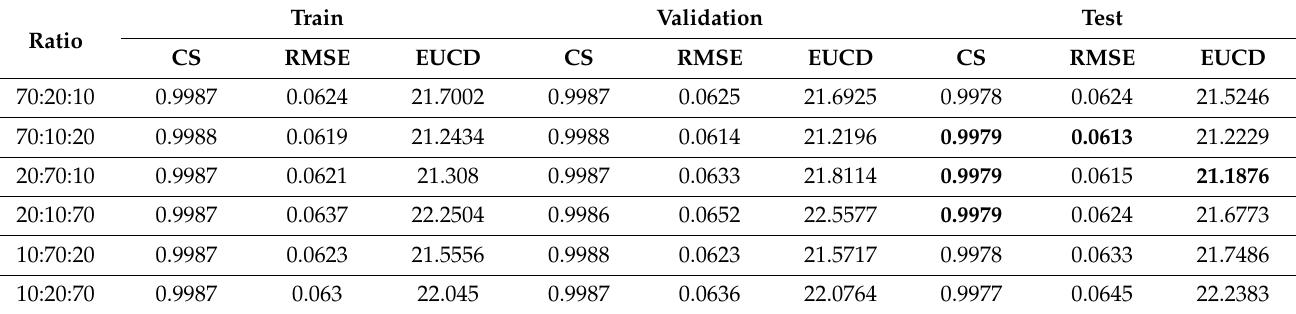
Table 3. Cross validation of ConvLSTM-SA model with self-attention.